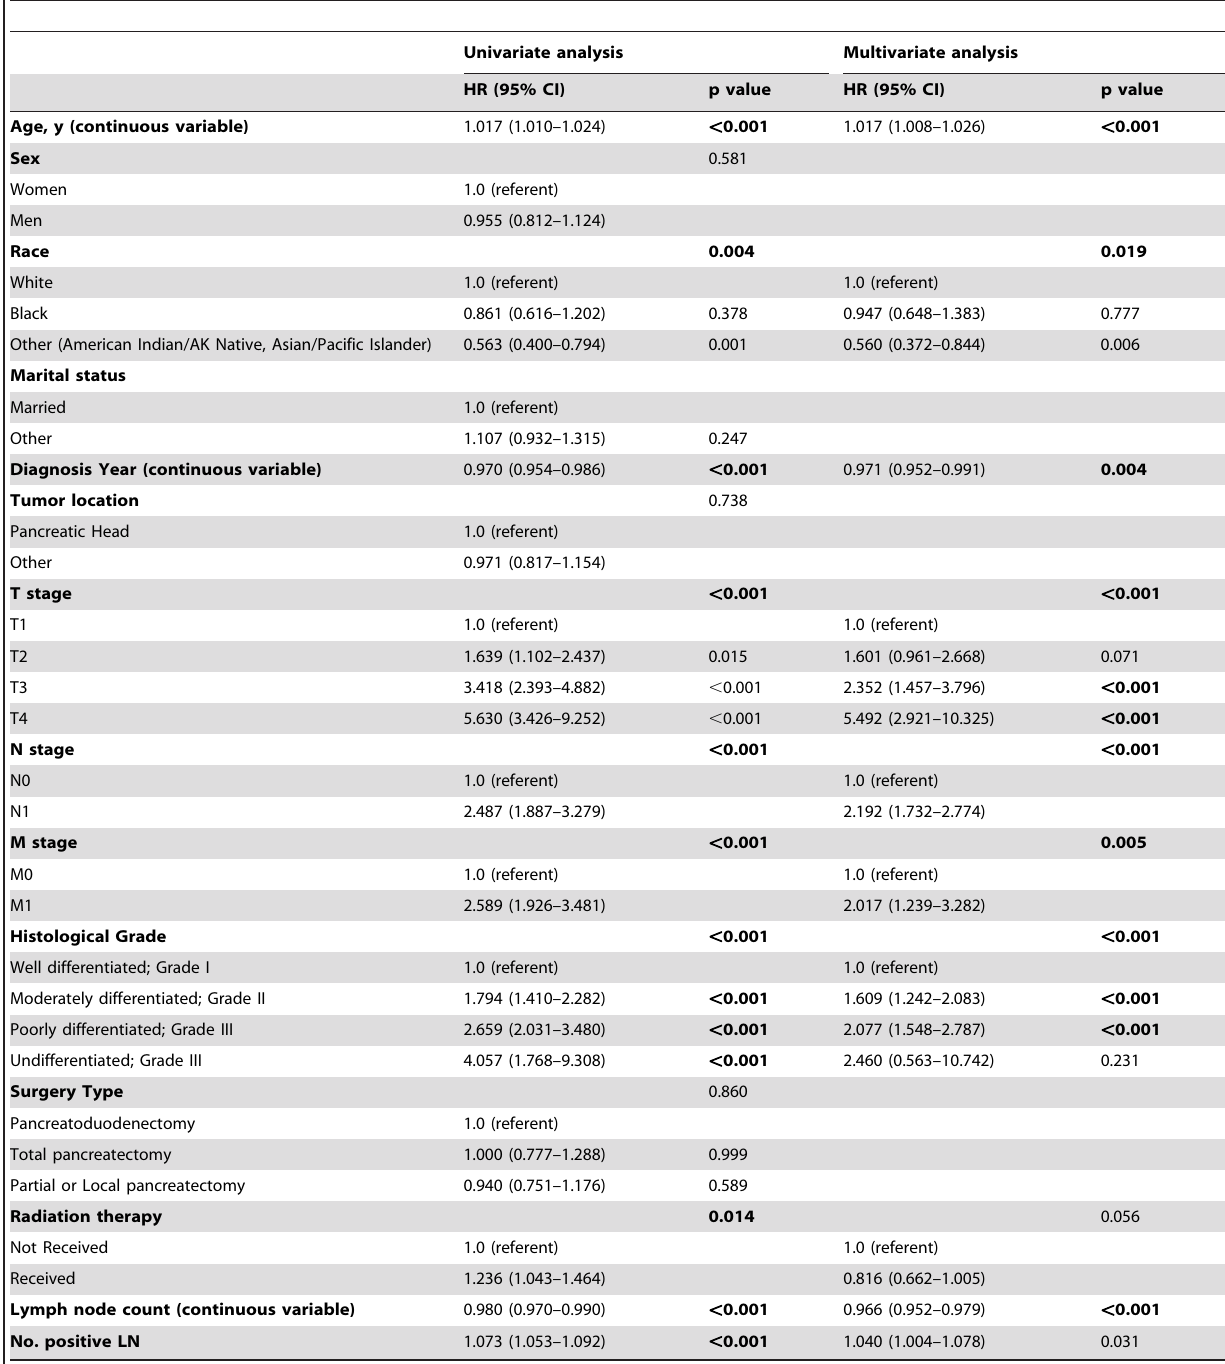
Table 2. Univariate and Multivariate Cox Proportional Hazard Regression Analyses for Cancer-Specific Survival in Invasive IPMN Patients: Surveillance, Epidemiology, and End Results, 1992 to